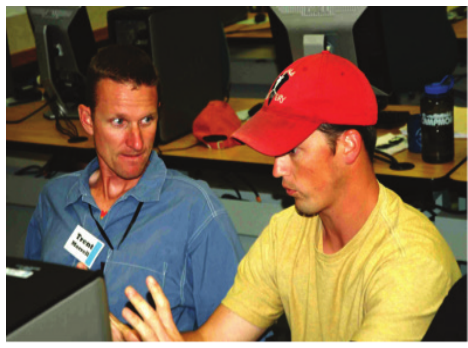
this… experience has had on me as an instructor, a geographer and geoscientist, and as a person.” Trent Morrell, Laramie County Community College (WY) here with Adam Dastrup, Salt Lake Community College (UT).